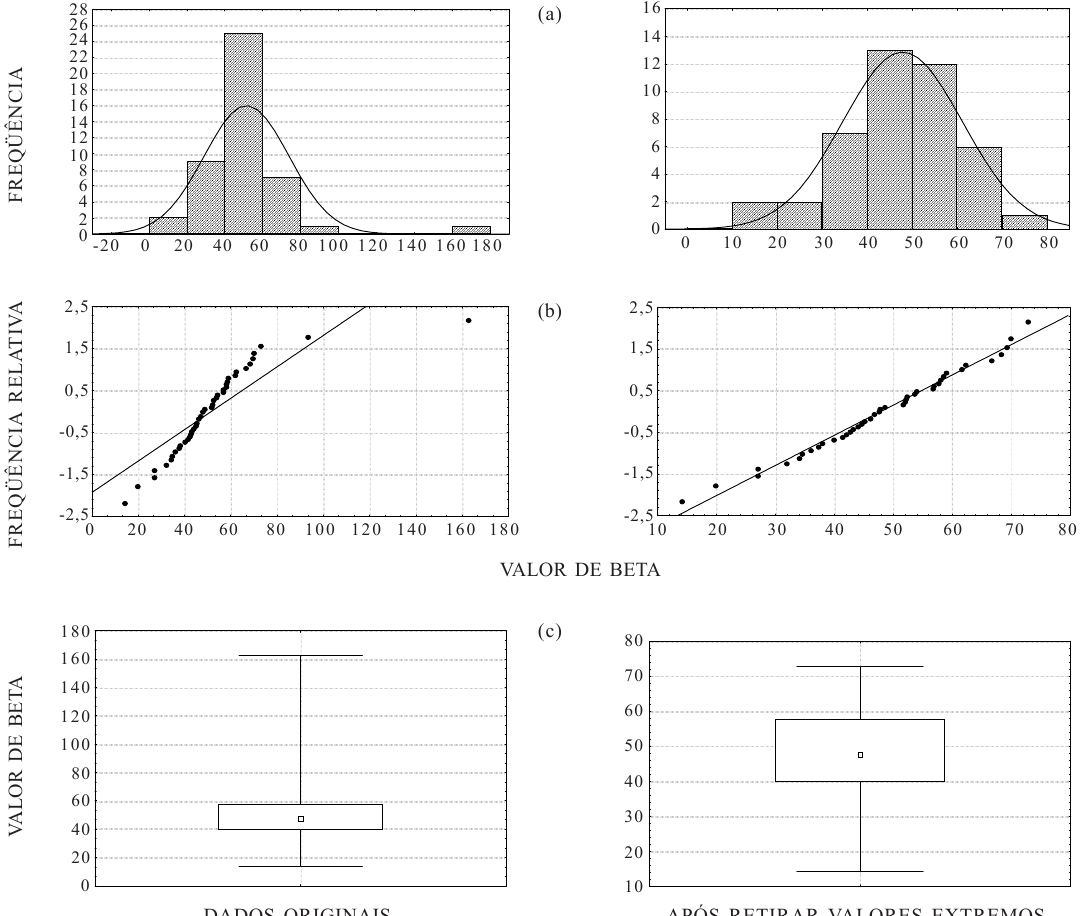
Figura 3. Histogramas de freqüência (a), retas de probabilidade de Henry (b) e gráfico “box-plot” (c), para βββββ , na profundidade de 0,30